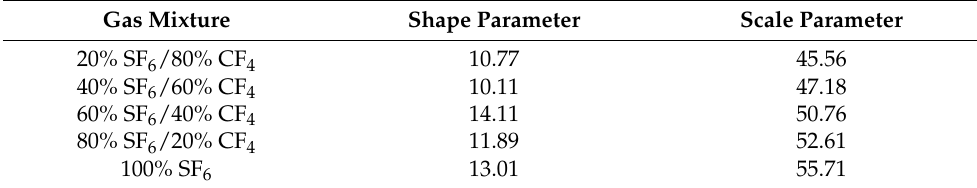
Figure 7. Weibull fitting of flashover voltage with a needle-plate electrode system. Table 2. Shape and scale parameters with a needle-plate electrode